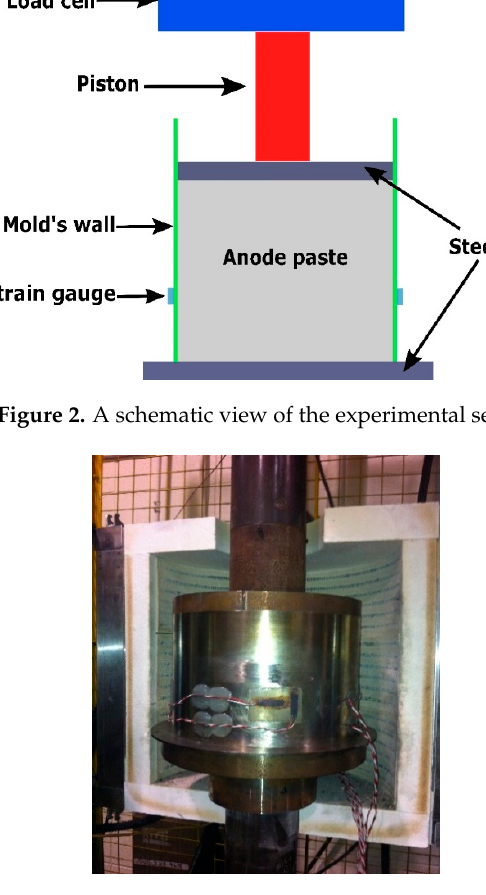
Figure 5. Circumferential strain at the mold wall vs. height ratio.